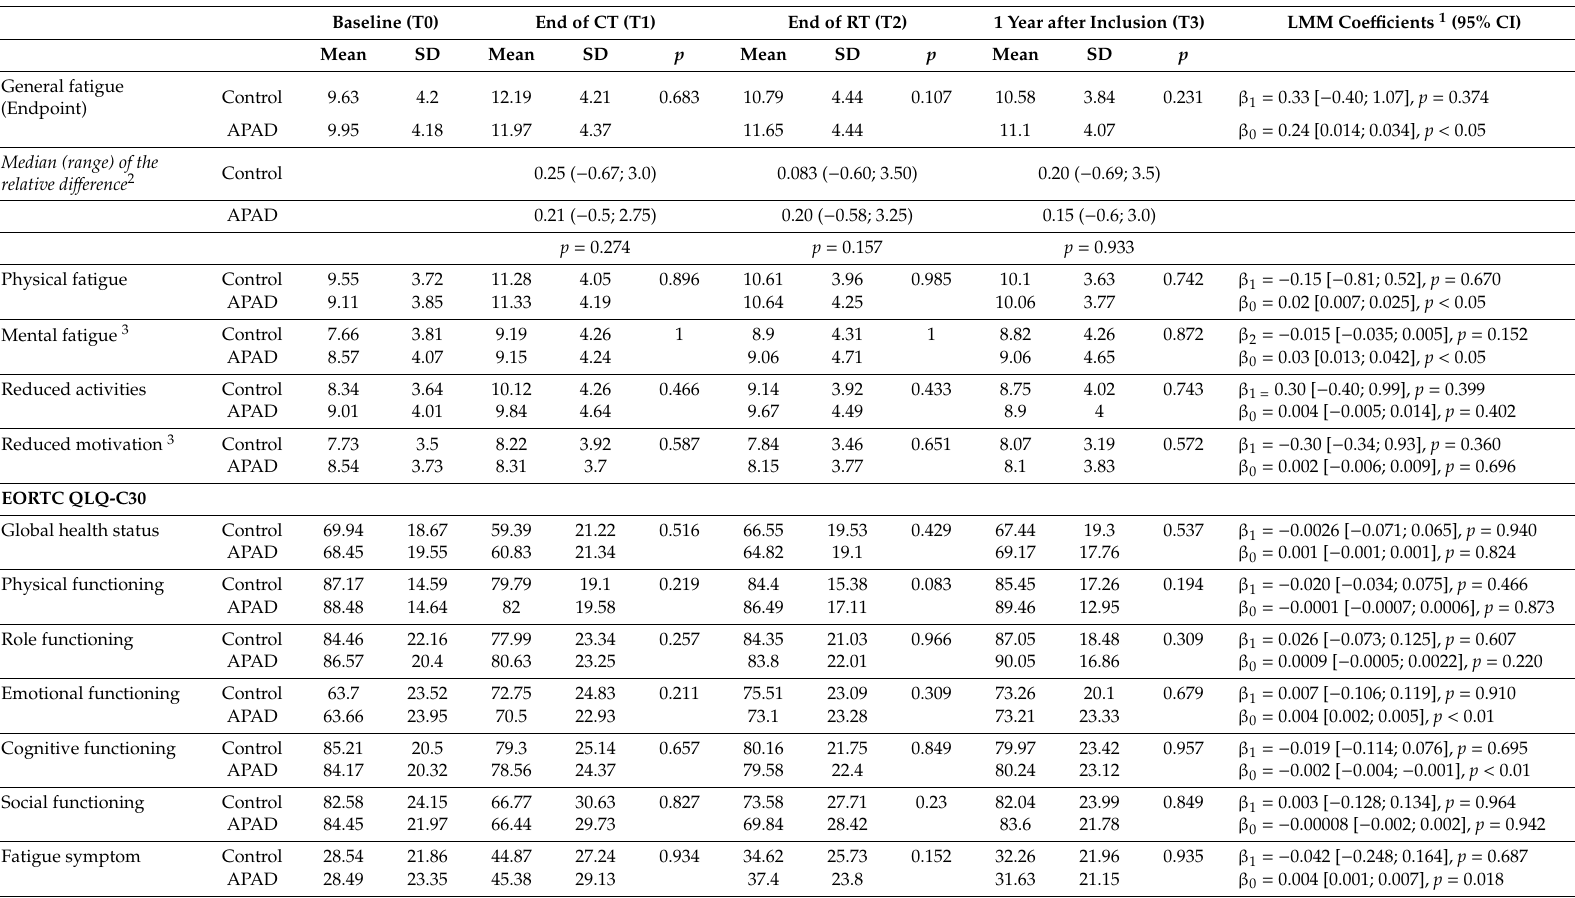
Table 2. Fatigue sub-scales of the MFI20 and quality of life (EORTC QLQ-C30) in the intention-to-treat